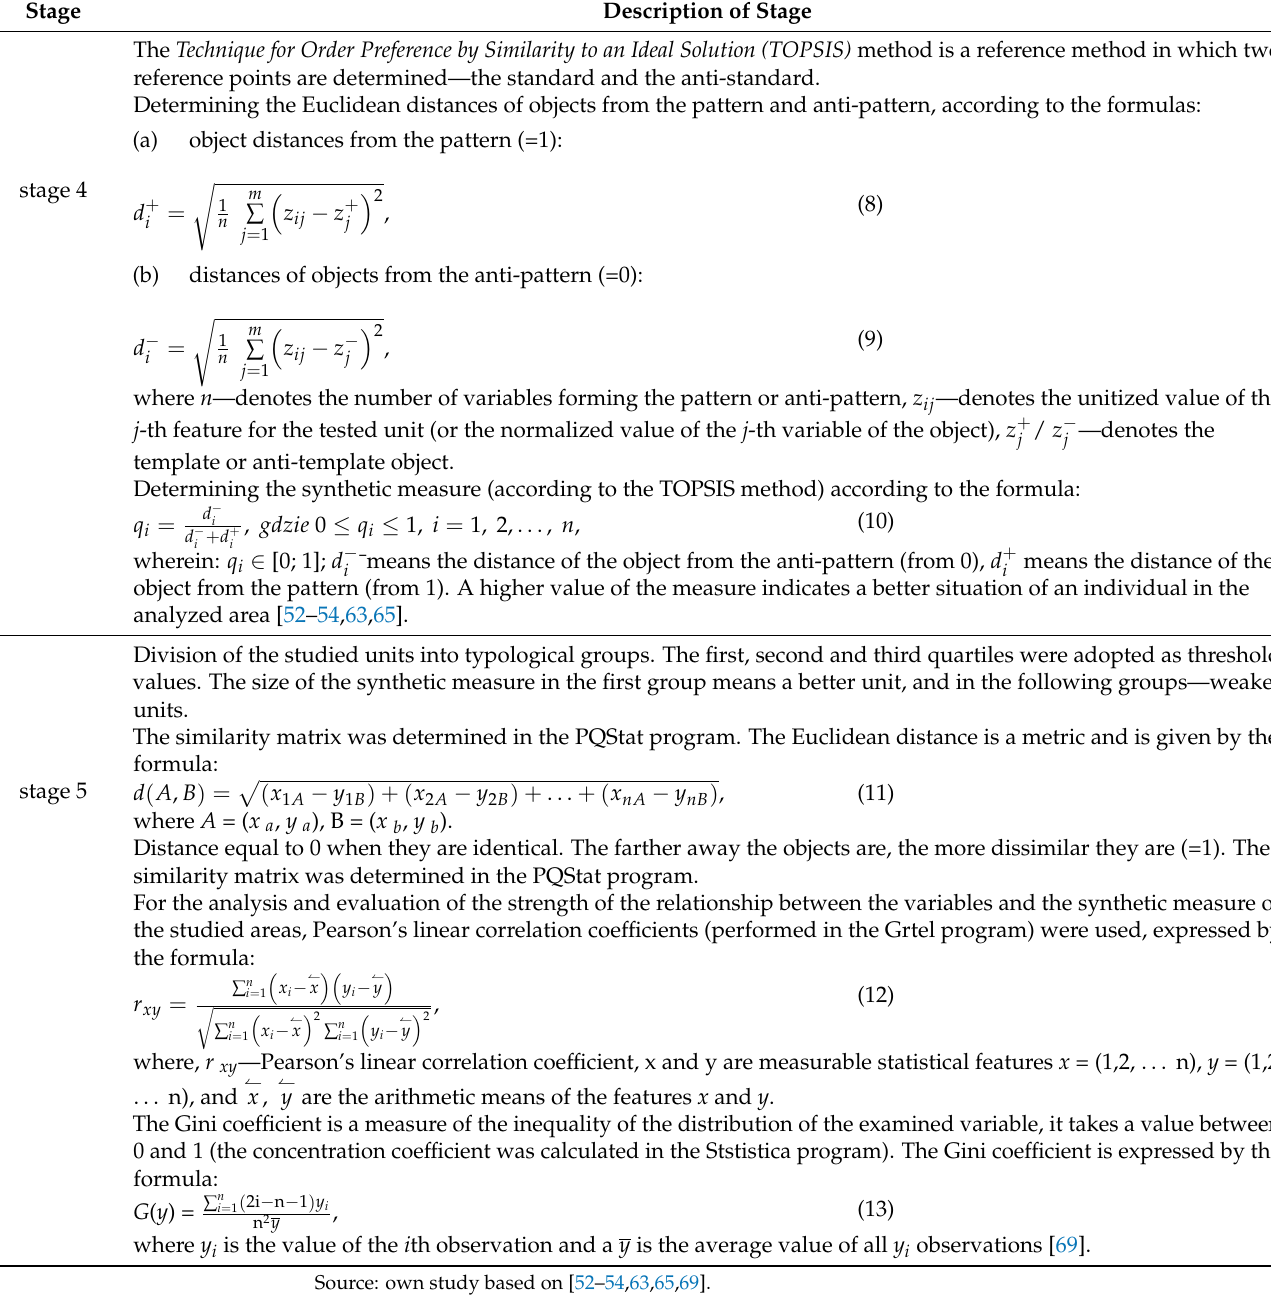
Table 4. Stages 4, and 5 of building a synthetic